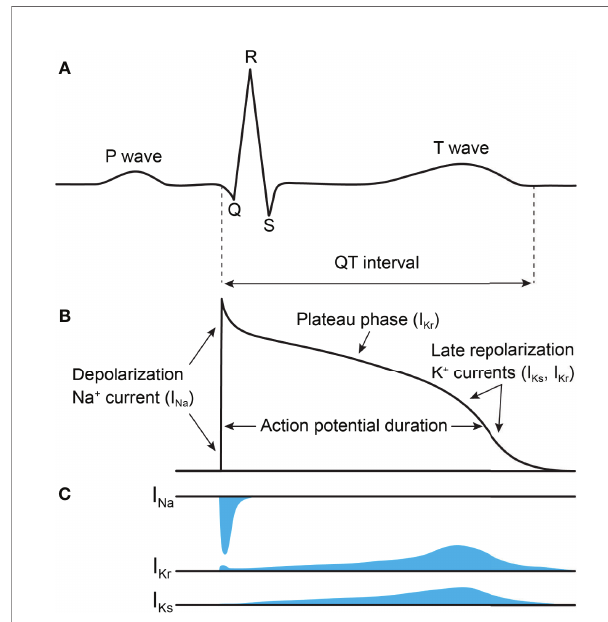
FIGURE 1 | Voltage-activated Na + and K + currents de fi ne the ventricular action potential and QT interval of the ECG. (A) ECG trace. The rapid upstroke of the ventricular action potential gives rise to the QRS complex. The duration of the QT interval is determined by the time of the ventricular repolarization. (B) Trace of the ventricular action potential. The rapidly activating and inactivating I Na current drives membrane depolarization. Two K + currents, I Ks and I Kr , contribute most to the plateau phase and repolarization phase of the action potential, which reestablishes the membrane resting potential. (C) Time course of I Na , I Kr , and I Ks currents (not drawn to scale). Currents of other ion channels contributing to the action potential (e.g. I Ca,L , I Kur , and I NCX ) are not shown for clarity. This fi gure is inspired by fi gures in Moss and Kass (2005) and George